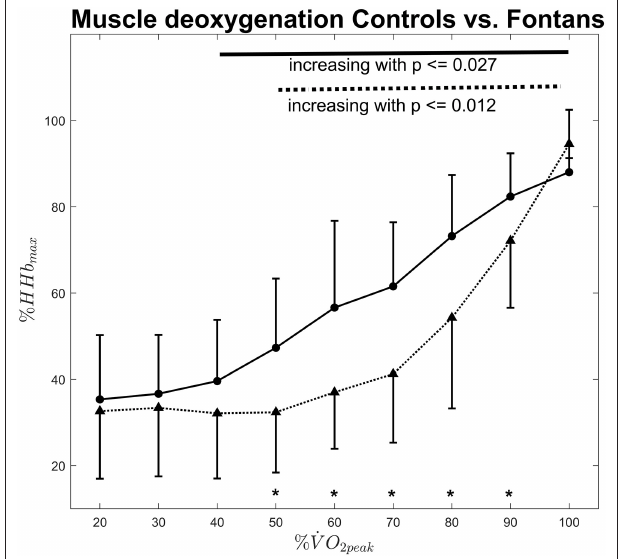
FIGURE 2 | Normalized muscle deoxygenation vs. exercise intensity for Fontans (solid line) and Controls (dashed line). The solid and dashed lines in the upper section indicate significant differences between intensities among Fontans and Controls, respectively. Significant differences ( p < 0.05) between Fontans and Controls within one exercise intensity are marked with